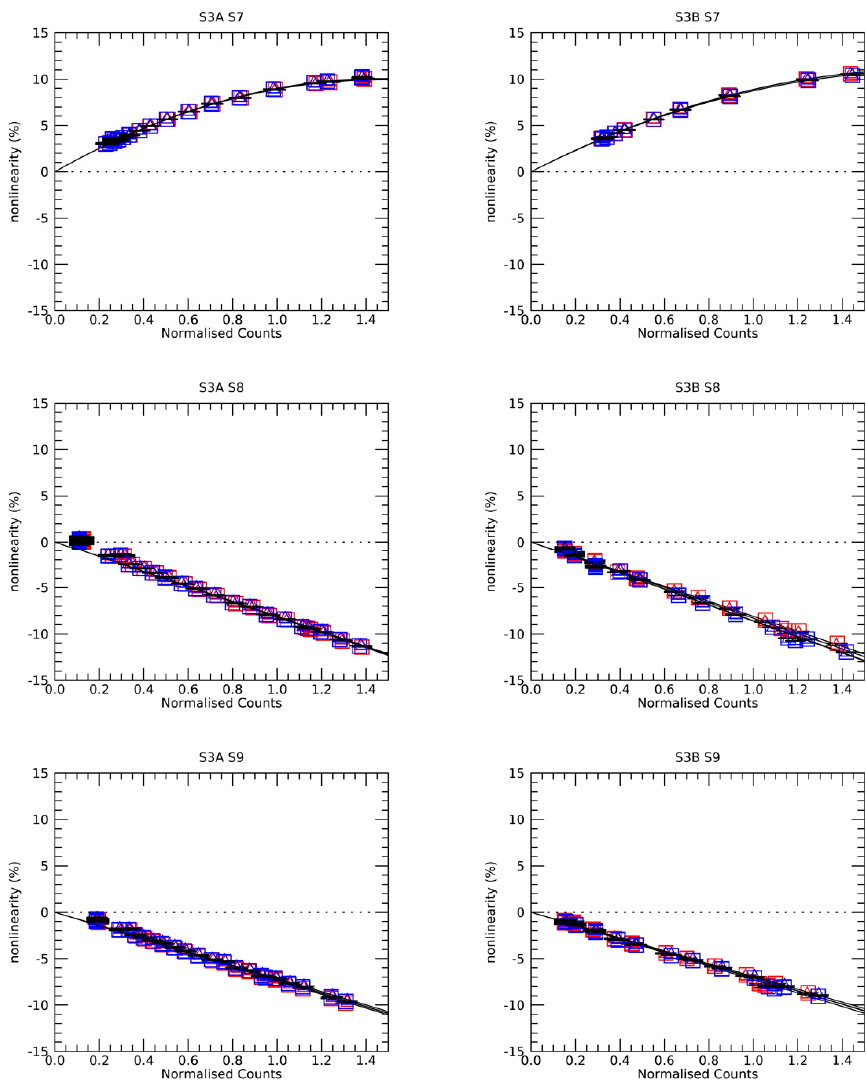
Figure 5. SLSTR-A (left) and SLSTR-B (right) non-linearity responses expressed as percentage for channels S7-S9. ☐ = Detector 1, Integrator 1; ☐ = Detector 1, Integrator 2; Δ = Detector 2, Integrator 1; Δ = Detector 2, Integrator 2.